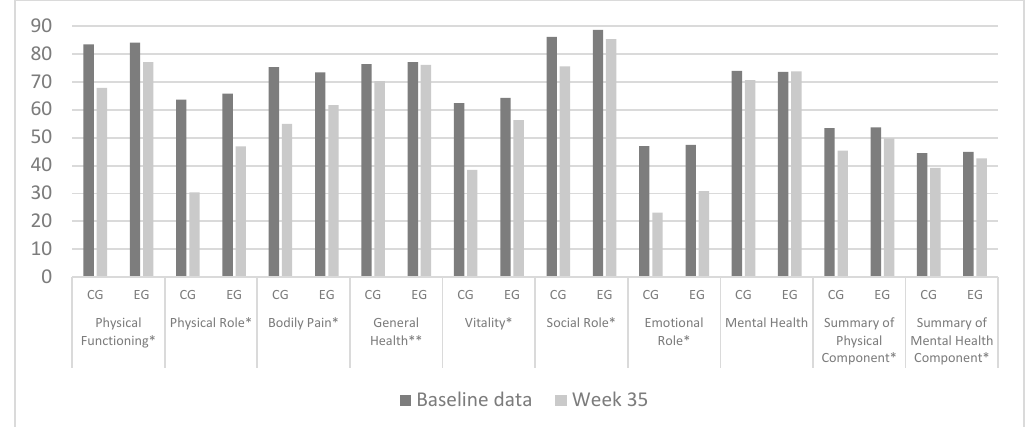
Figure 2. SF36v2 scores for CG vs. EG.